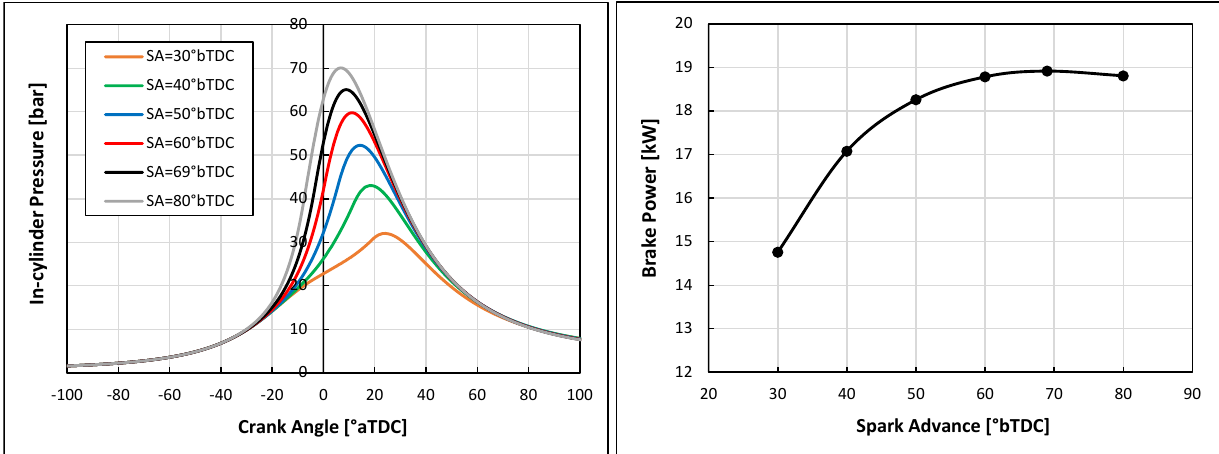
Figure 5. In-cylinder pressure ( left ) and brake power ( right ) for different spark advances; 1500 rpm, ϕ = 1. WOT, no boost. Table 6. Combustion characteristics and engine performance; 1500 rpm, ϕ = 1, WOT, no boost.